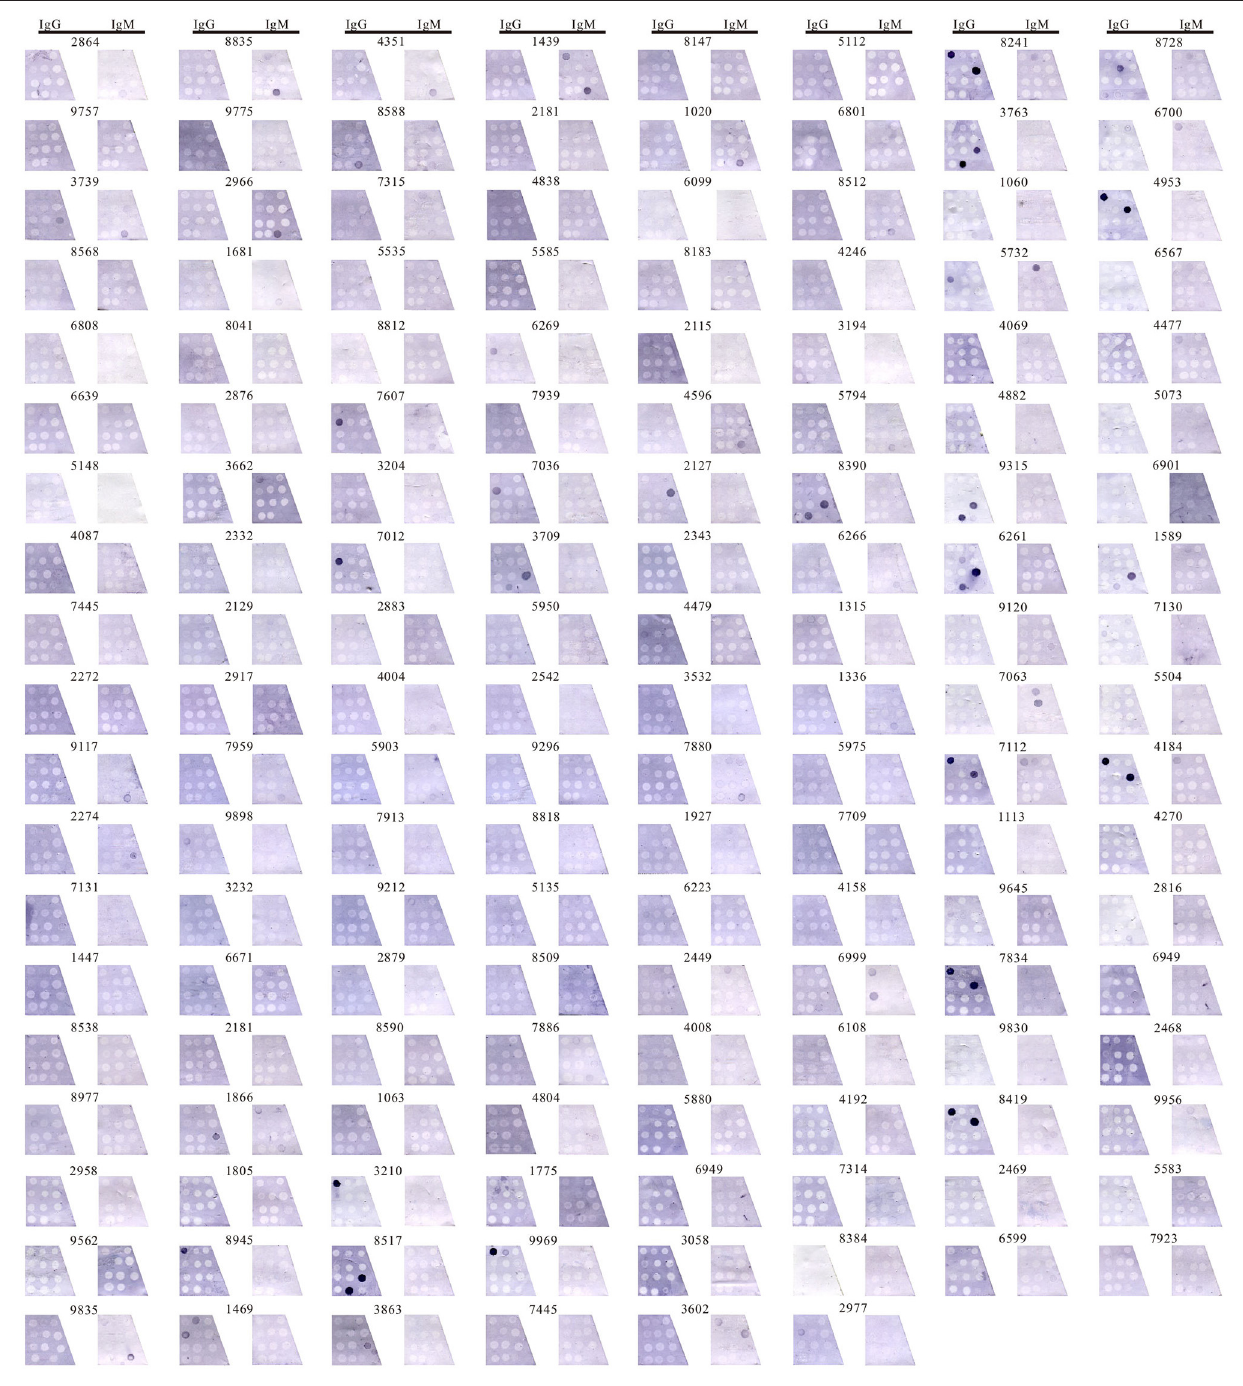
in patients with GBS were 35 and 87%, showing a slightly lower sensitivity and higher specificity than previous reports. That result may form a stricter criterion in selection of the patients and more precise result interpretation. However, in